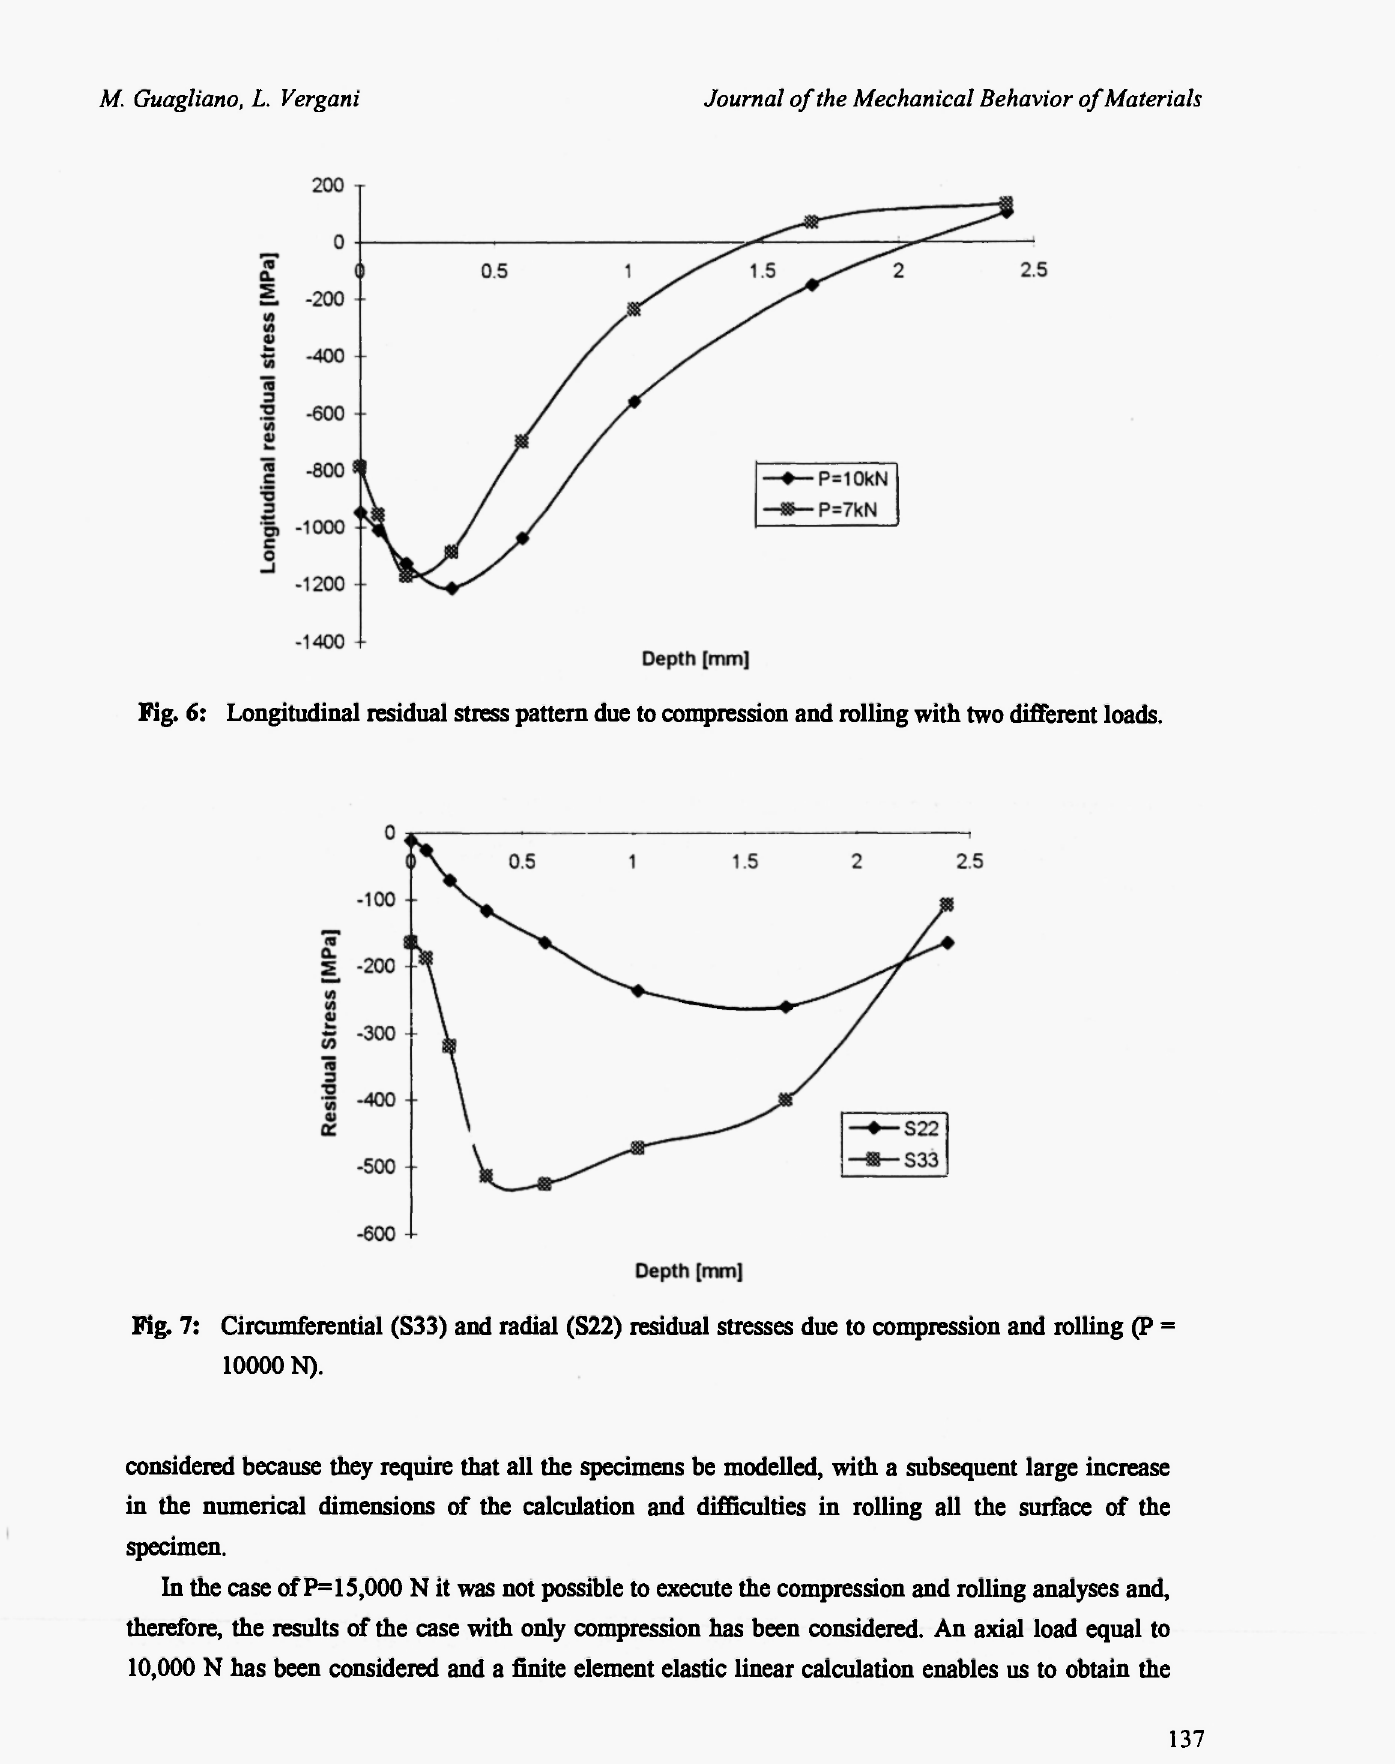
Fig. 7: Circumferential (S33) and radial (S22) residual stresses due to compression and rolling (P = 10000